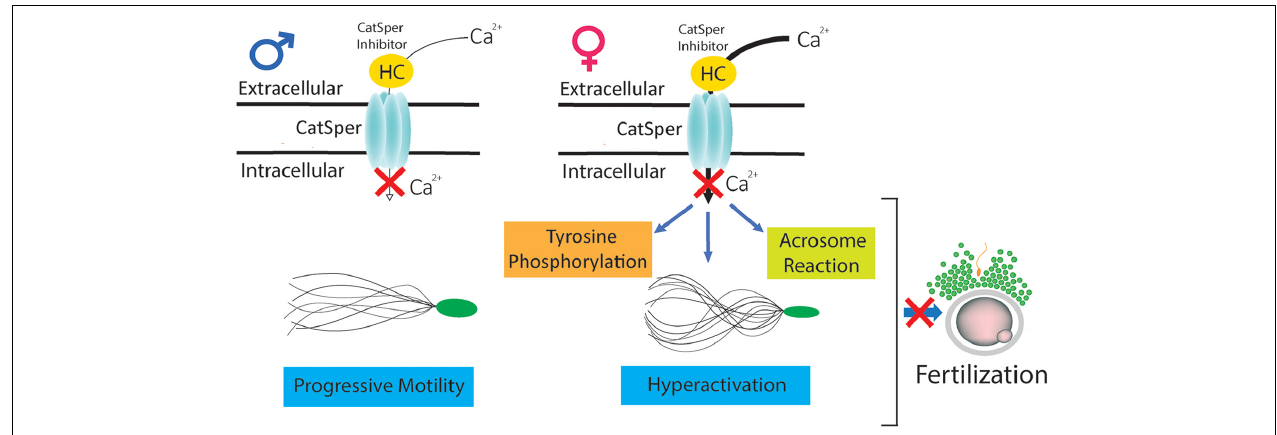
FIGURE 6 | Mechanisms underlying the effects of HC on sperm fertilizing ability. CatSper inhibitor HC is capable of interacting with sperm before (in the male) as well as during or after capacitation (in the female), inhibiting calcium entry into the cells and leading to defects in several capacitation-associated functional events (i.e., tyrosine phosphorylation, acrosome reaction, hyperactivation) that finally block the sperm fertilizing ability.